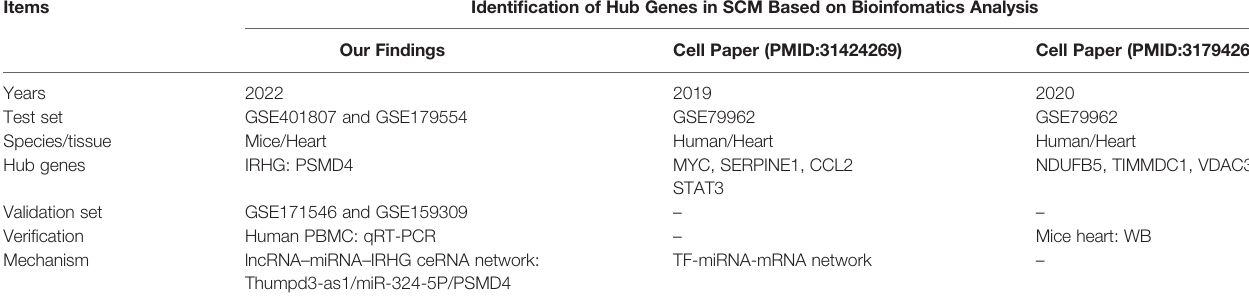
TABLE 4 | Several fi ndings in this study are signi fi cantly novel in comparing to what is